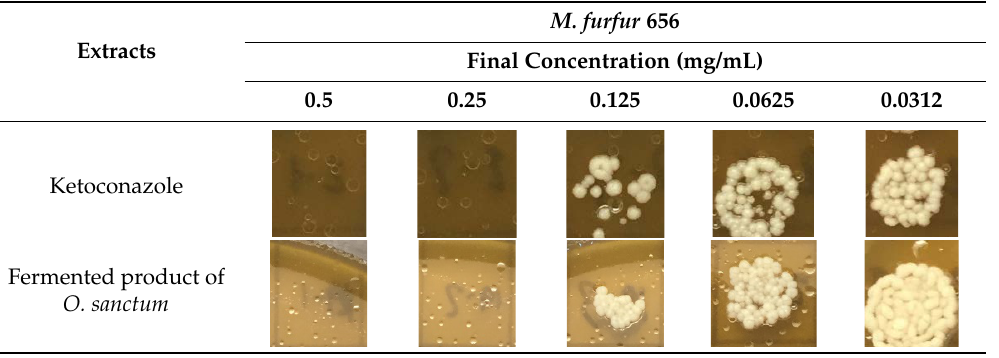
Table 4. MFCs of ketoconazole and Fermented-bio of O. sanctum against M. furfur 656 at different concentrations.